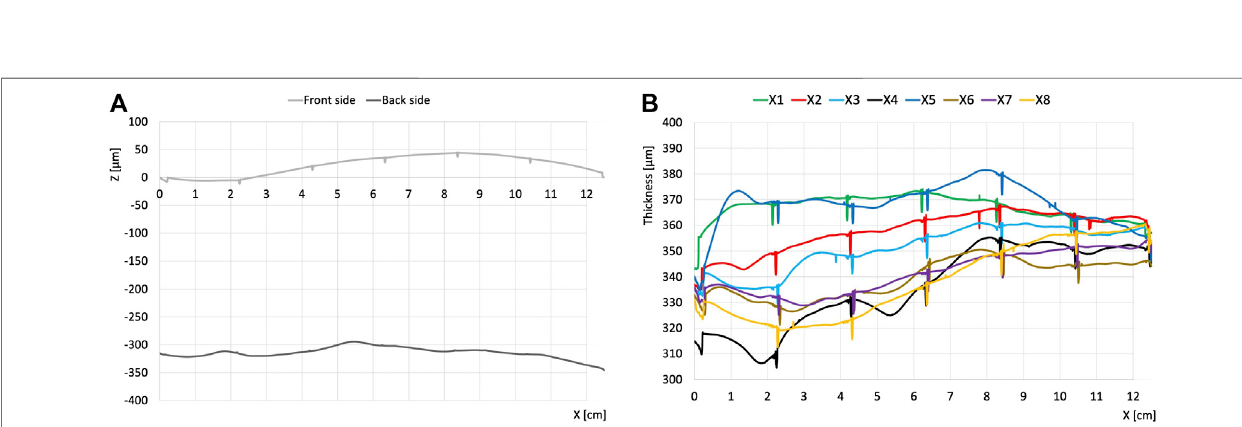
FIGURE 8 | (A) front (gray) and back (black) pro fi les for WLP 6, X4: the distance between the two pro fi les is taken as the wafer thickness (B) distance extracted in the described procedure, for eight lines along the X axis of WLP 6. Combining the results, the average thickness of WLP 6 is 350 ± 16 μ m.